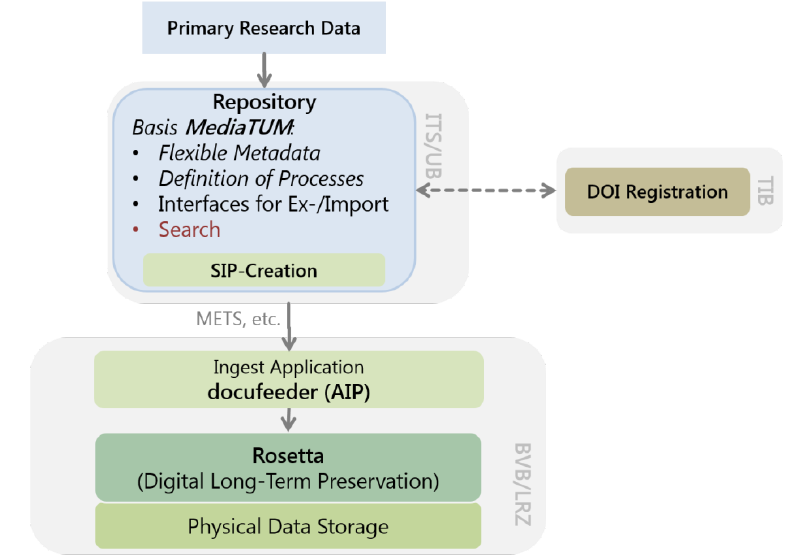
Figure 3. Implementation of Long-Term Preservation of Research Data in CRC 840.